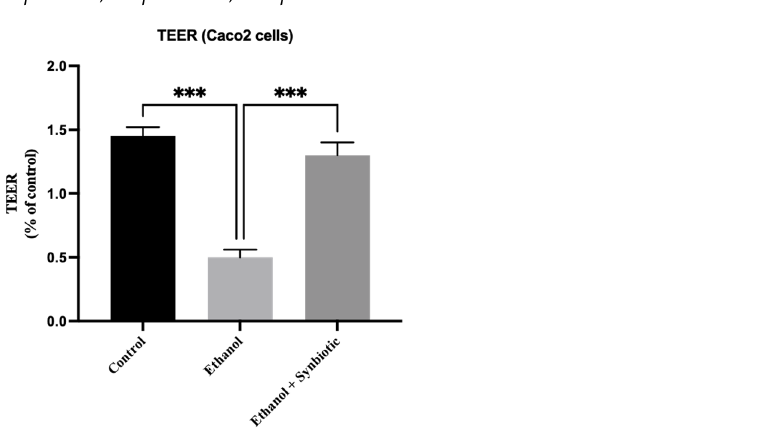
Figure 3. TEER assessment of Caco-2 integrity: TEER investigation of the impact of probiotics and AGE individually or as synbiotic on the functionality of the intestinal barrier produced by ethanol in monolayers of Caco-2 cells. The statistical analysis was calculated as mentioned in Section 2.10. Mean − /+ SD was determined for N = 6 replicates. For statistical analysis, GraphPad Prism 7 and one-way ANOVA in conjunction with the Tukey post hoc test were calculated. When associated with the ethanol group, significance ( p -value) is defined as *** p < 0.001.